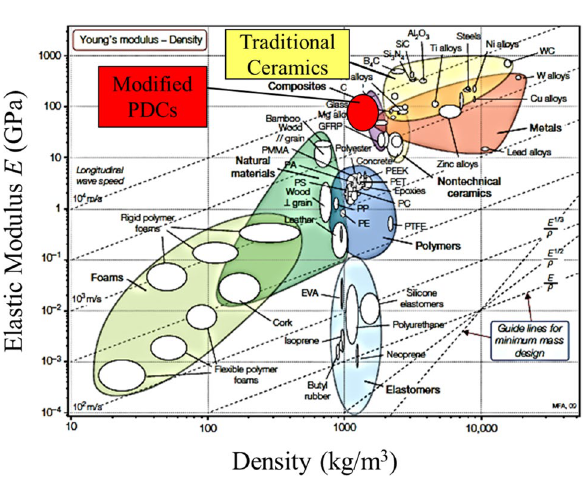
Figure 5. The comparison between mechanical properties of PDCs and other materials. The Ashby charts for modulus—density, showing the properties of PDCs (the chart is adapted from 40 , with